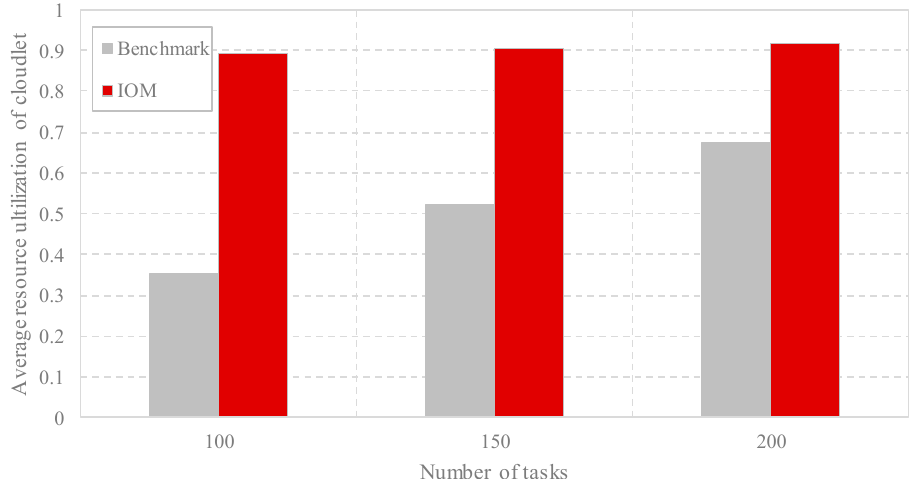
Figure 5. Comparison of the average resource utilization of the cloudlets with different task scales by Benchmark and IOM.